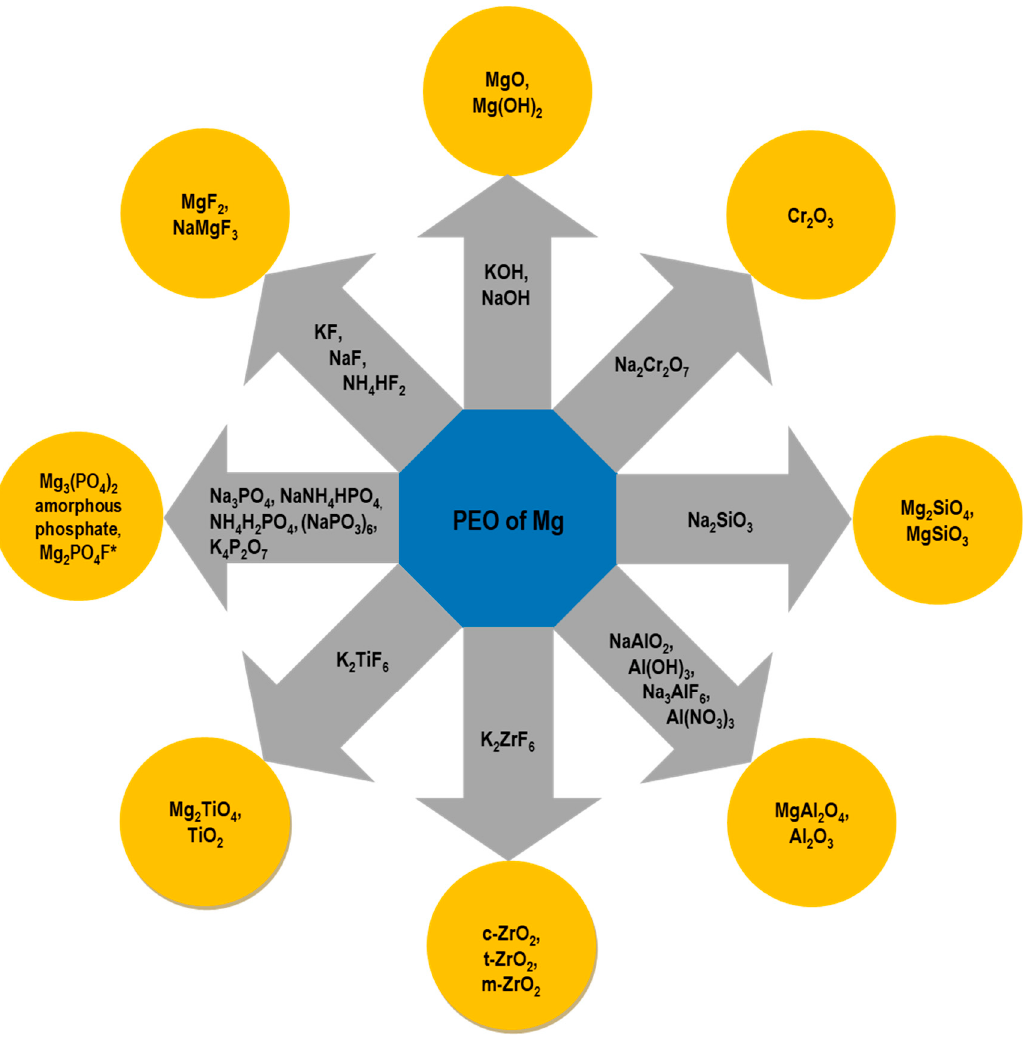
Figure 6. General overview of the most frequently used electrolytes components and phases formed in the PEO process on Mg. * Phase formed in a presence of K 2 TiF 6 .